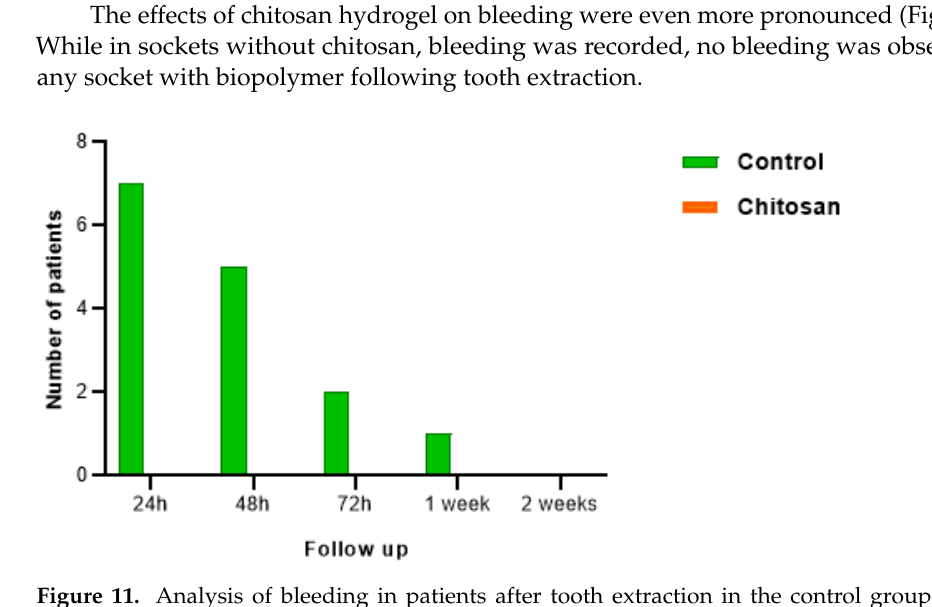
Figure 11. Analysis of bleeding in patients after tooth extraction in the control group and the experimental (chitosan) group.